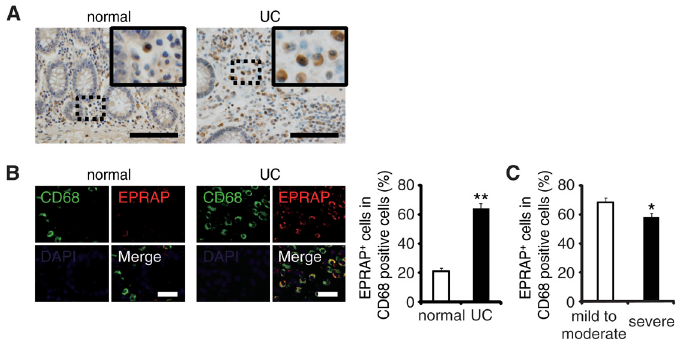
show higher magnifications of selected regions (indicated by dash boxes). Scale bars: 100 μ m. (B) Double- color immunofluorescence analyses using sections of normal and UC colons were performed with anti-CD68 (green) and anti – EPRAP (red) antibodies (left). Scale bars: 20 μ m. The percentage of EPRAP-positive cells in CD68-positive cells (right) (n = 20 [normal]; n = 20 [UC]). ** P < 0.01 vs. normal colons. (C) Relationship between the percentage of EPRAP positive cells in CD68-positive macrophages and the clinical severity of UC patients (mild to moderate vs. severe) (n = 22 [mild to moderate]; n = 16 [severe]). * P <